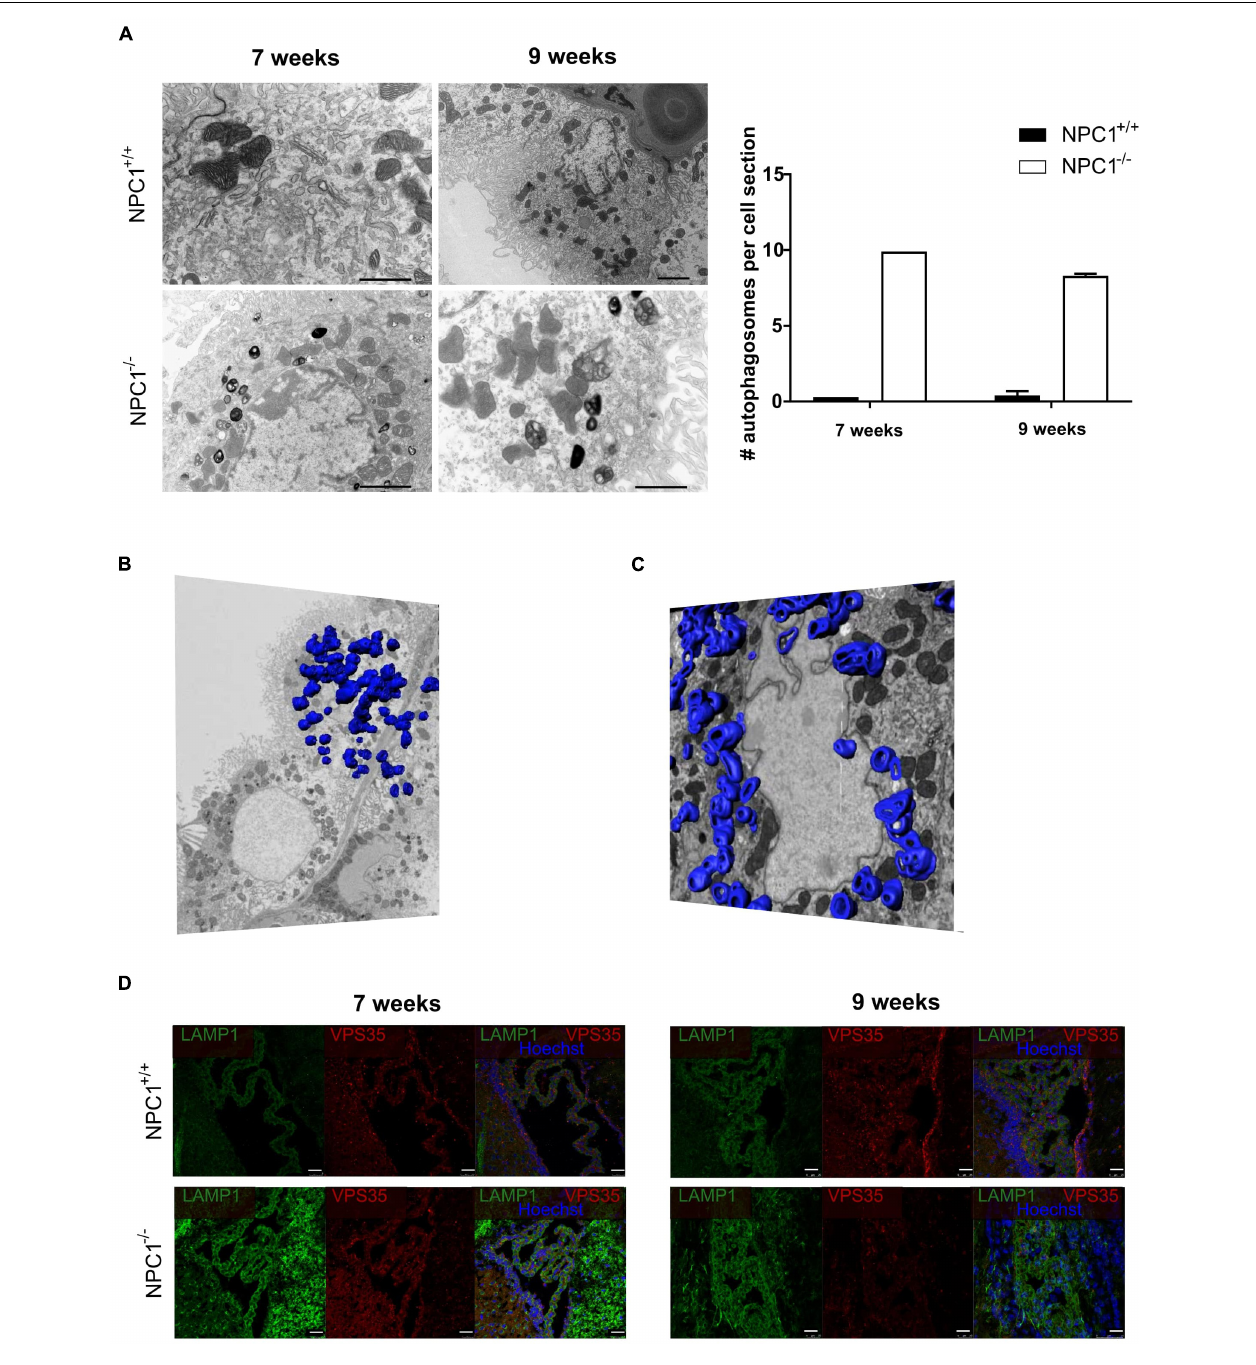
FIGURE 3 | NPC1 − / − mice show a huge increase in autophagosomes in the choroid plexus epithelial cells. (A) Representative transmission electron microscopy (TEM) images of choroid plexus epithelial cells of the fourth ventricle of NPC1 + / + and NPC1 − / − mice (7 and 9 weeks old). Scale bar represents 10 µ m. The graph represents the amount of autophagosomes per cell section in 7 and 9 weeks old NPC1 + / + (black) and NPC1 − / − (white) mice ( n = 3). (B) Representative serial block face scanning electron microscope (SBF-SEM) snapshot of Supplementary Video 1 of a choroid plexus epithelial cell of the fourth ventricle of a 9 weeks old NPC1 − / − mouse. The autophagosomes are traced on the different sections and visualized in blue ( n = 1). (C) Representative focused ion beam scanning electron microscopy (FIB-SEM) snapshot of Supplementary Video 2 of a choroid plexus epithelial cell of the fourth ventricle of a 9 weeks old NPC1 − / − mouse. The autophagosomes are traced on the different sections and visualized in blue ( n = 1). (D) Representative images of LAMP1 staining (green) and VPS35 (red) of the choroid plexus of the fourth ventricle of NPC1 + / + and NPC1 − / − mice of 7 and 9 weeks old. Cell nuclei are counterstained with Hoechst (blue) ( n = 4–5). Scale bar represents 25 µ